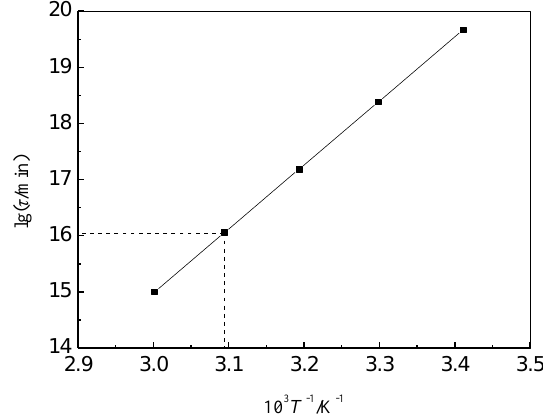
Figure 6. Prediction of estimated lifetime for α τ = 95%.